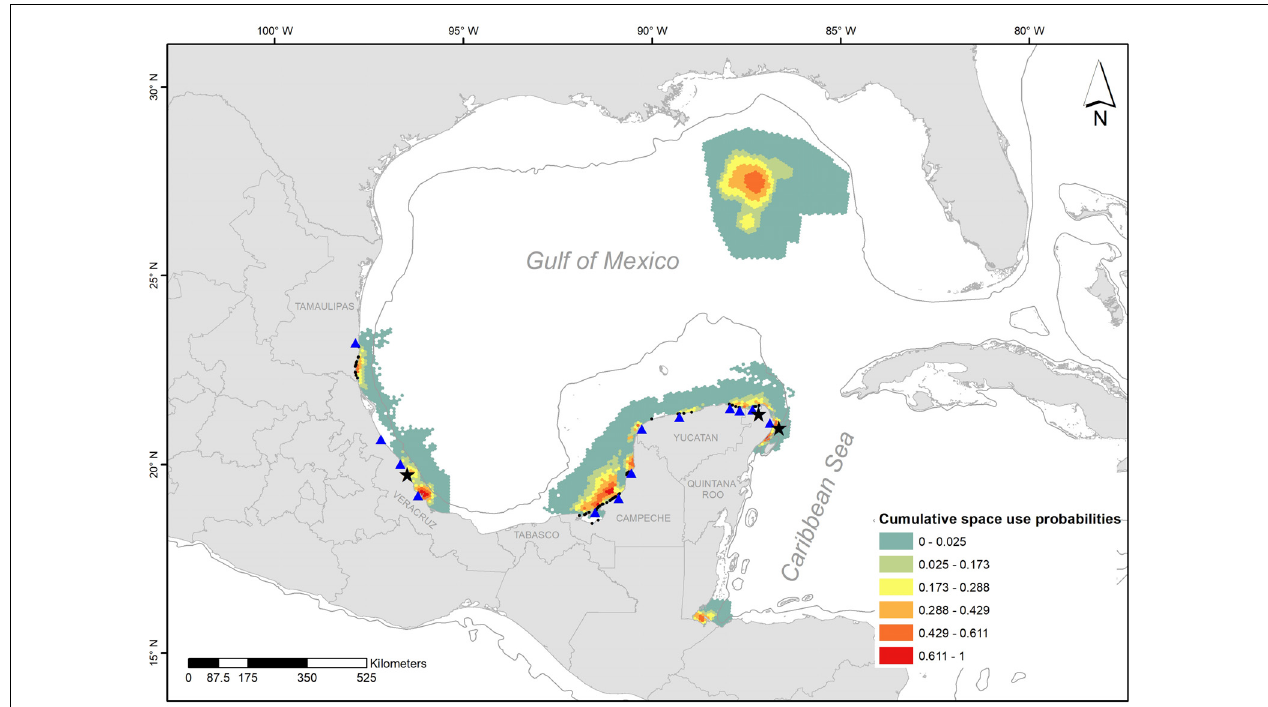
FIGURE 4 | Cumulative space use probabilities for adult male individuals of C. caretta , C. mydas, E. imbricata, and L. kempii . The black points on the shoreline represent the sites of stranding records, the black stars are point locations where mating couples of green and loggerhead individuals have been recorded, and the blue triangles are some of the main sea turtle nesting beaches in the